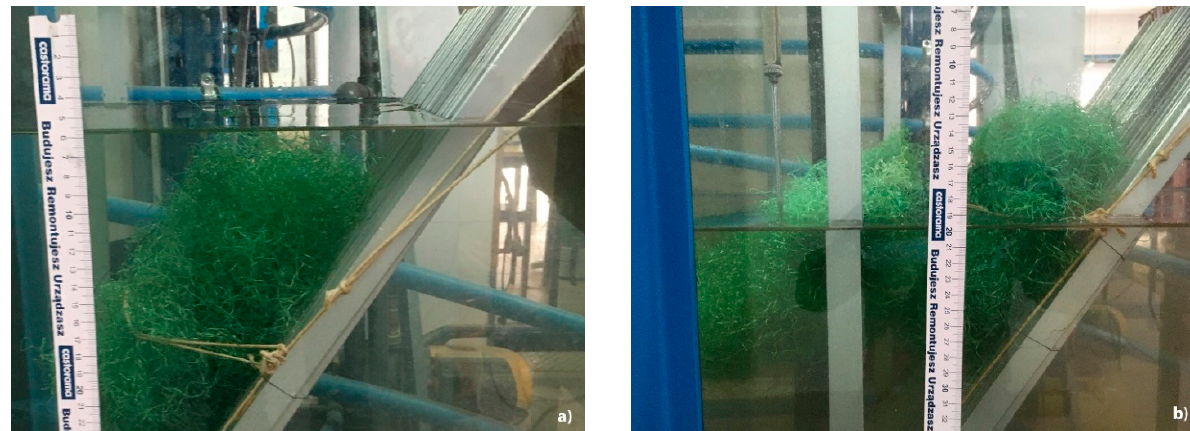
Figure 2. Rectangular form of plant debris found on SHP grids: ( a ) fully submerged; ( b ) half-submerged.